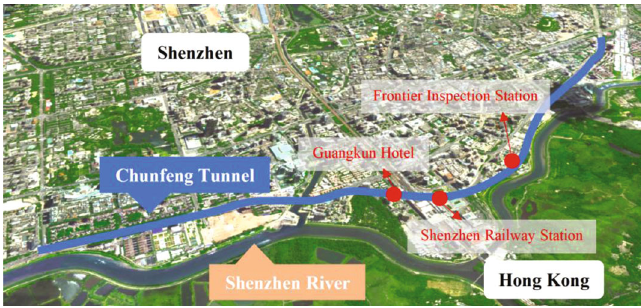
Figure 1: Chunfeng tunnel